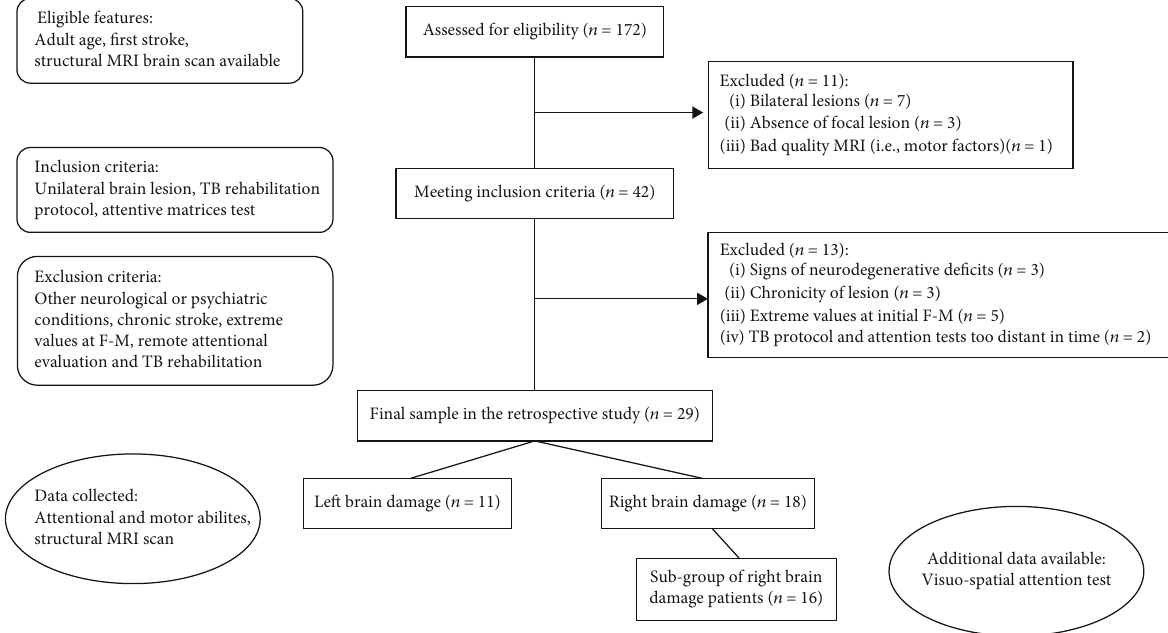
Figure 1: Enrollment fl owchart. MRI: Magnetic Resonance Imaging; TB: Technology-based; F-M UE: Fugl-Meyer Upper Extremity